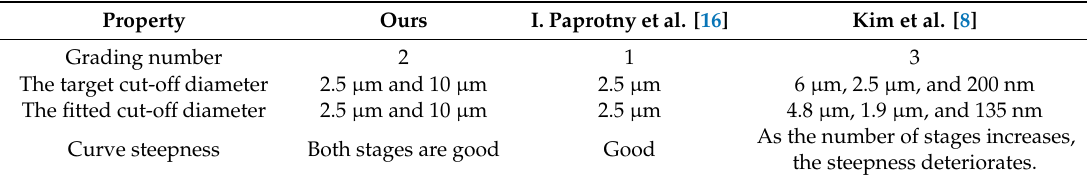
Table 2. Comparison with other microfluidic channels for PM flow dynamics analysis. Property Ours